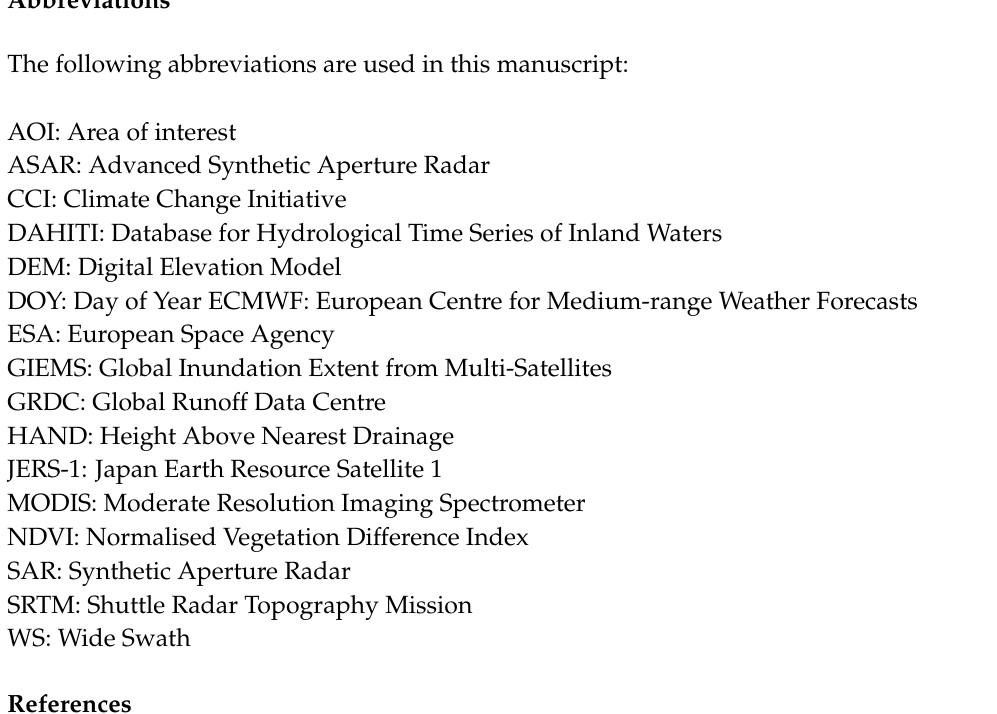
Figure S5: RGB composite of harmonic model components used for wetland extent mapping in the Kafue River Basin; Figure S6: Box-Whisker-Plots of the Height Above Nearest Drainage (HAND) index for each of the derived